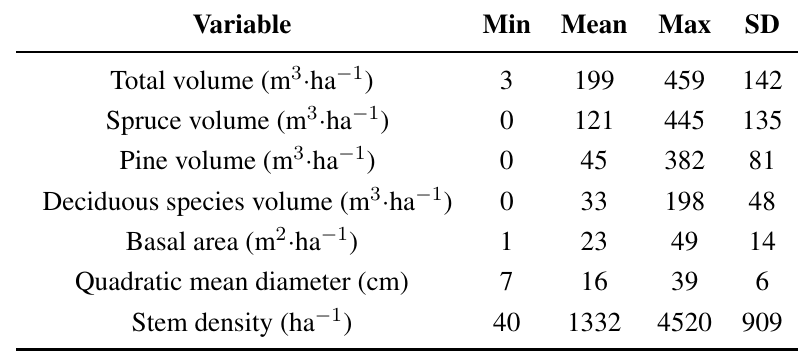
Table 1. Descriptive statistics of the 40 National Forest Inventory (NFI)